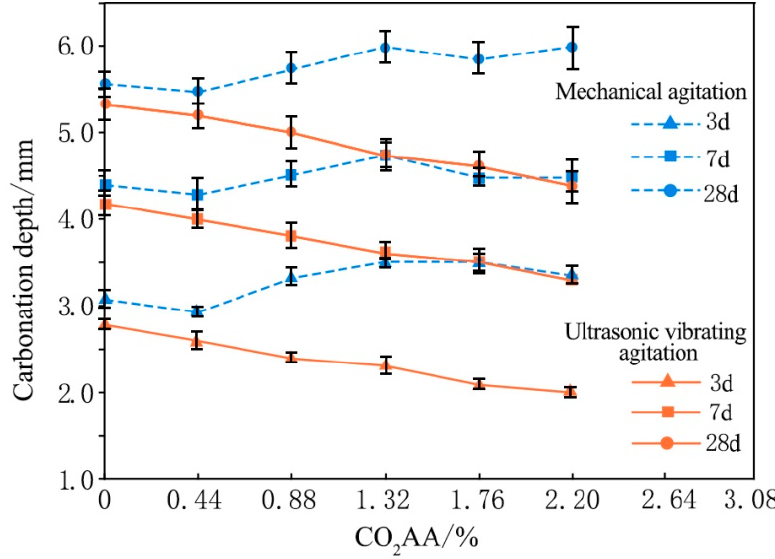
Figure 8. Carbonization depth curves of different CO 2 absorption stages.